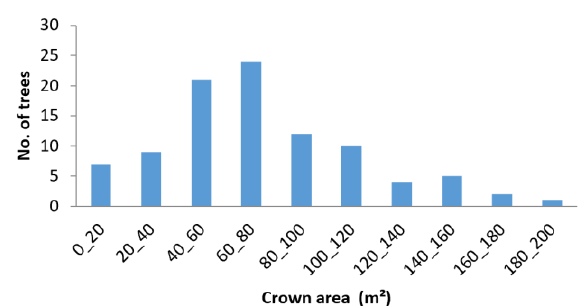
Figure 10. Tree categories as per Crown Area